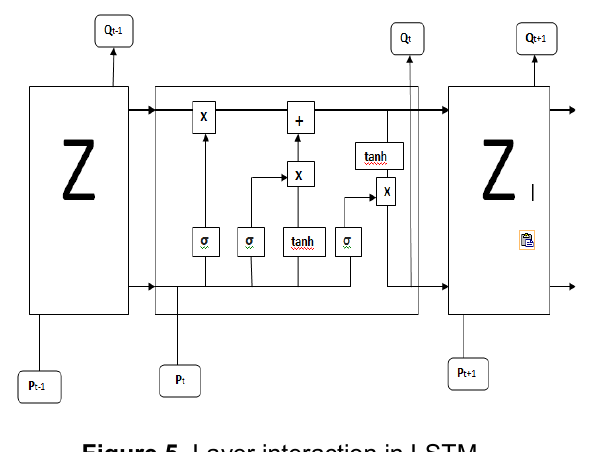
Figure 5. Layer interaction in